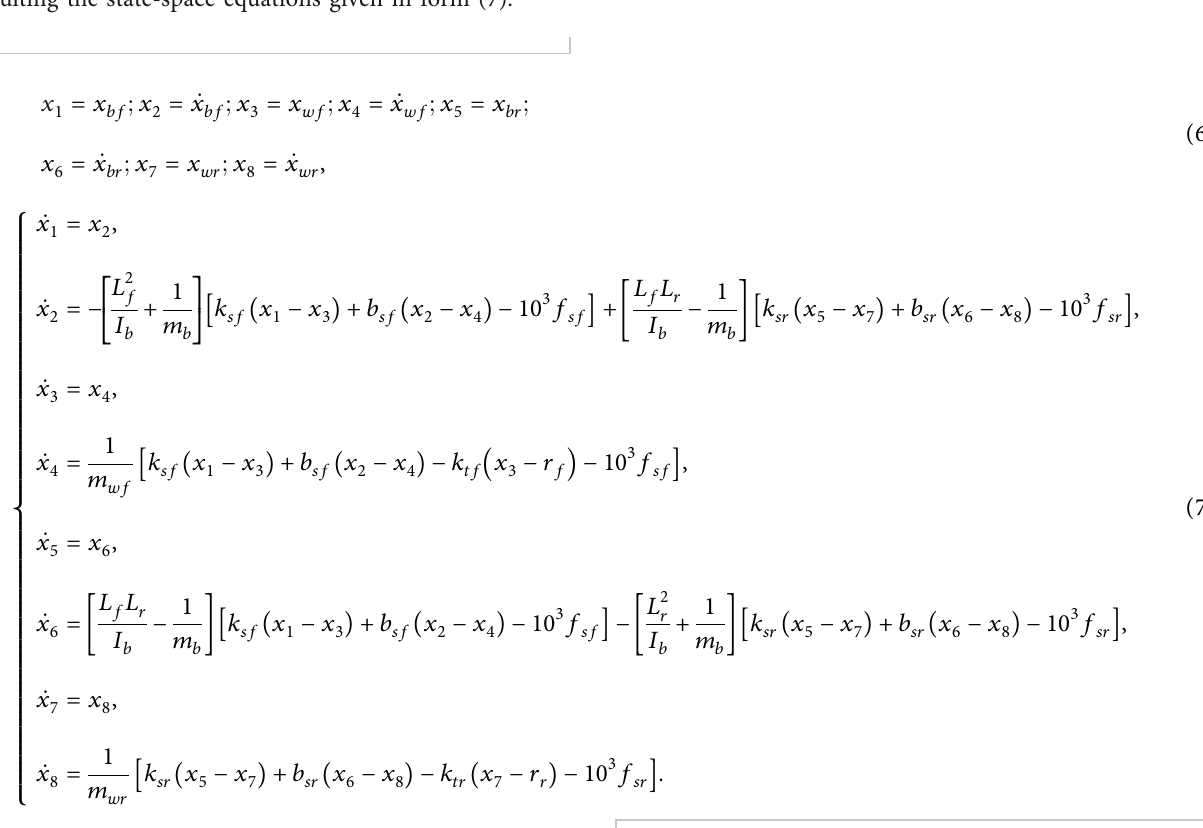
and rear body acceleration which indicate the passenger comfort. The state-space equations in form (7) together with the chosen input-state-output variables defined in Table 1 de- scribe the state-space representation of the system given in (8) and (9).